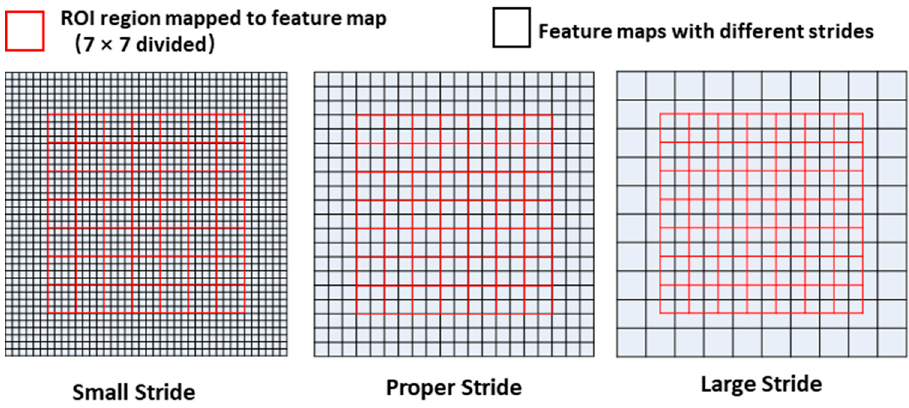
Figure 7. Appropriate feature stride for ROI pooling.